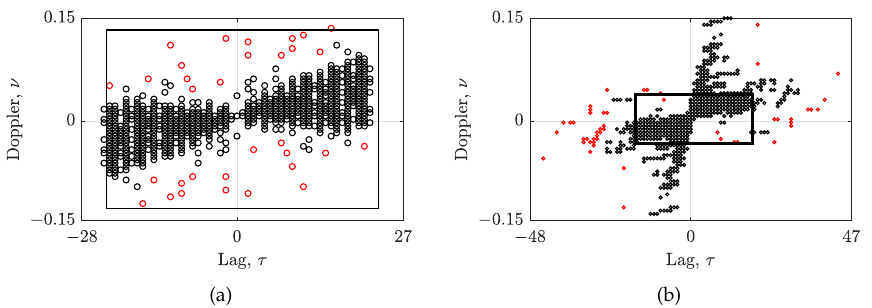
Figure 2. The clustered CS-AF area C Ω , whose samples are marked by black circles, of: ( a ) z SS , with Γ = 0.06, Υ = 0.5; ( b ) z RS with Γ = 0.15, Υ = 0.18. Outlier/noise samples are marked by red circles, while the automatically selected N (cid:48) τ × N (cid:48) ν area is marked by a black rectangle.